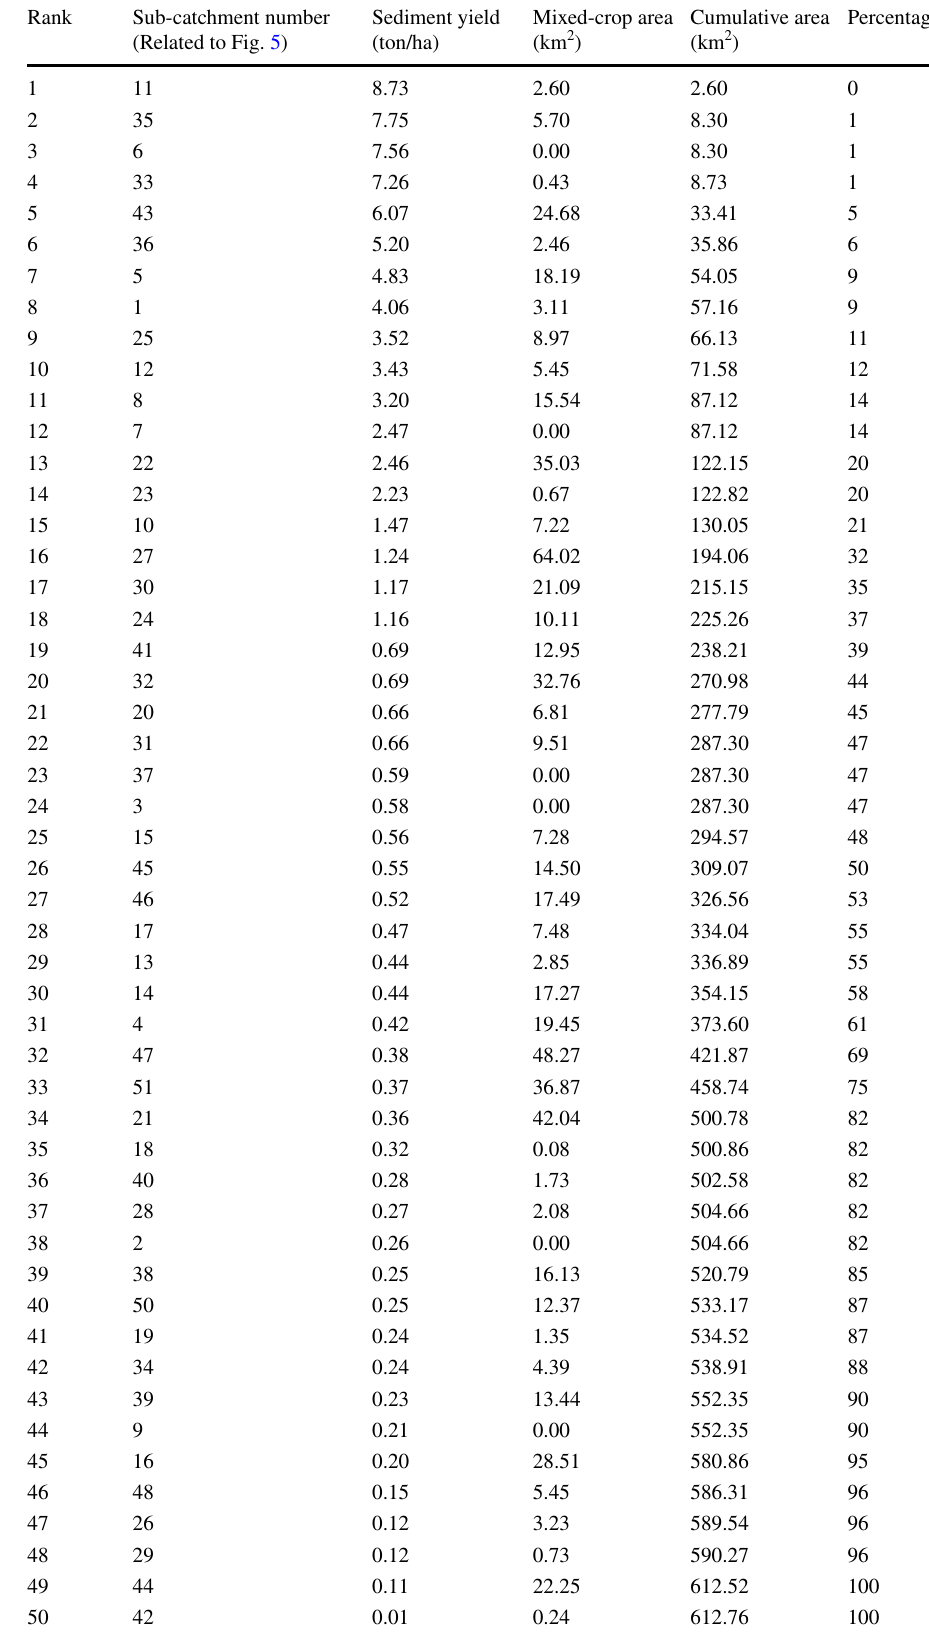
sub-watershed for the application of